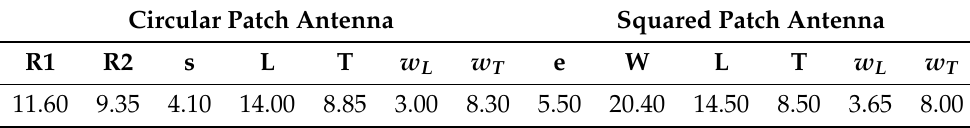
Table 3. Final dimensions of both optimized textile antennas [mm].